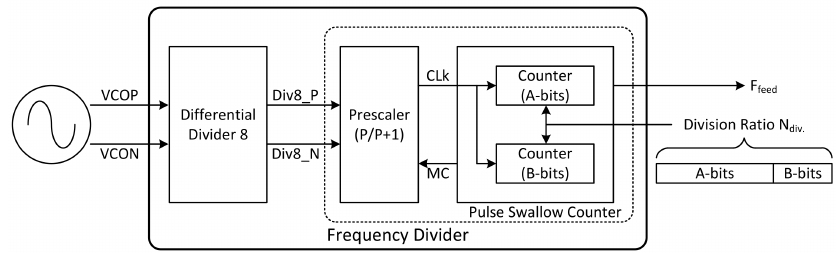
Figure 11. The overall block diagram of the frequency